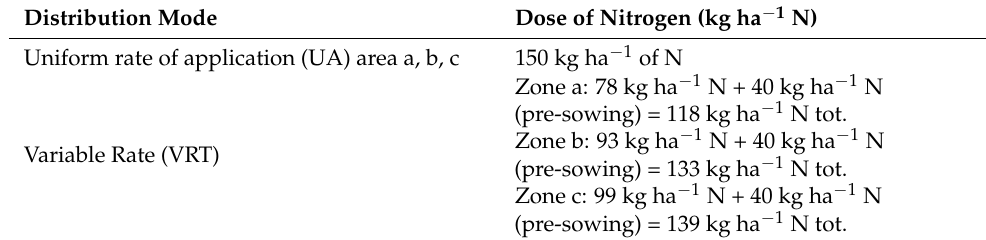
Figure 2. Experimental site area visualization and relative soil sample position. Table 1. Nitrogen management of site 1.